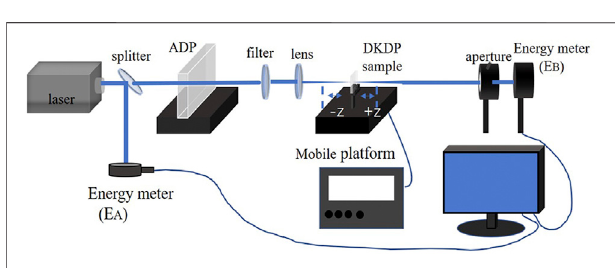
FIGURE 4 | The schematic representation of the Z-scan experimental setup (samples were taken from four different positions).